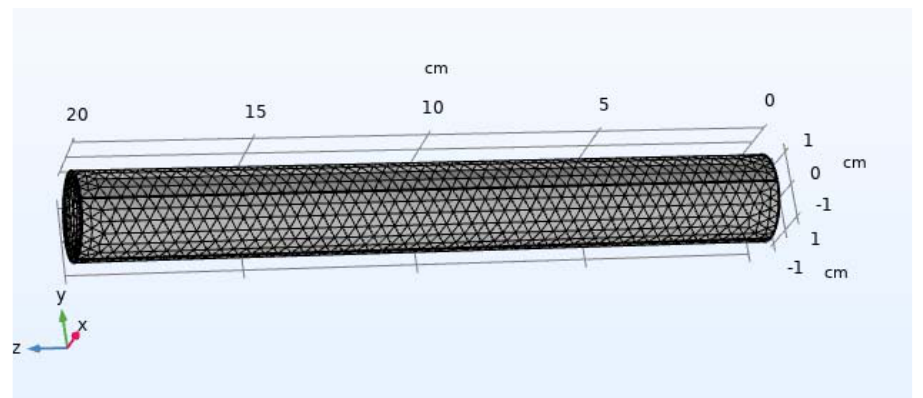
Figure 7. The geometric model used for the simulation study.